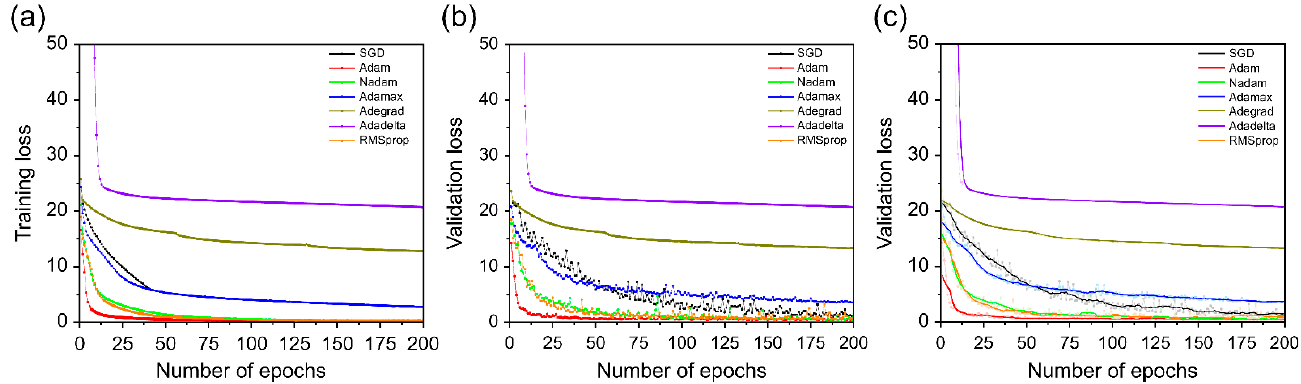
Figure 10. Loss curves comparing various optimizers. ( a ) Training loss; ( b ) validation loss; ( c ) validation loss using moving average.